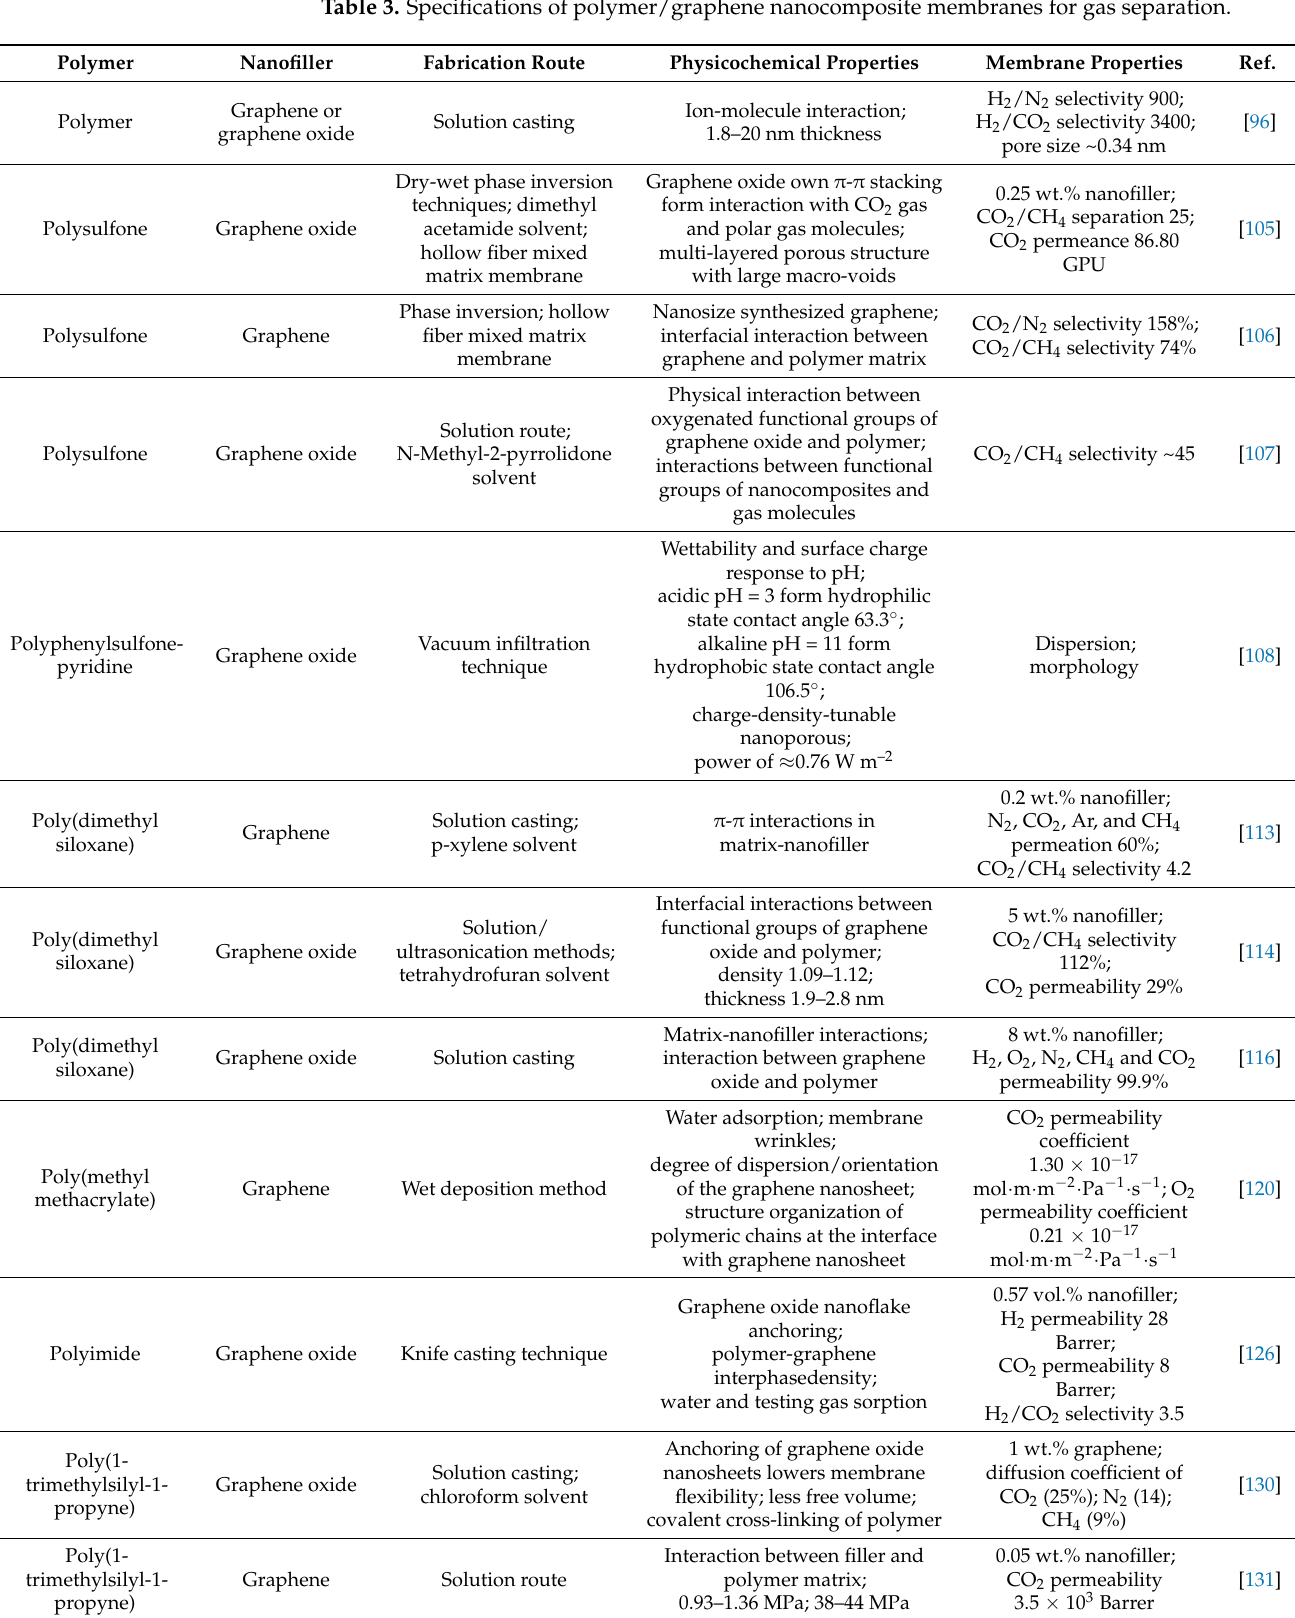
Table 3. Specifications of polymer/graphene nanocomposite membranes for gas